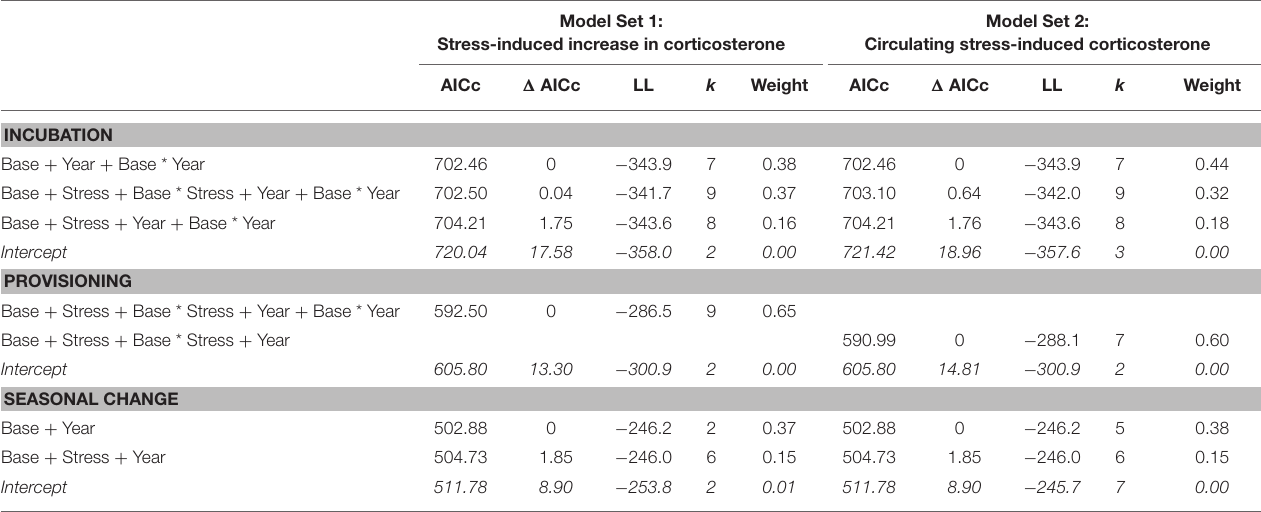
TABLE 1 | Model comparisons of the predictors of reproductive success in female tree swallows, showing all candidate models within 2 1 AICc of the best-fit model, and the null model.